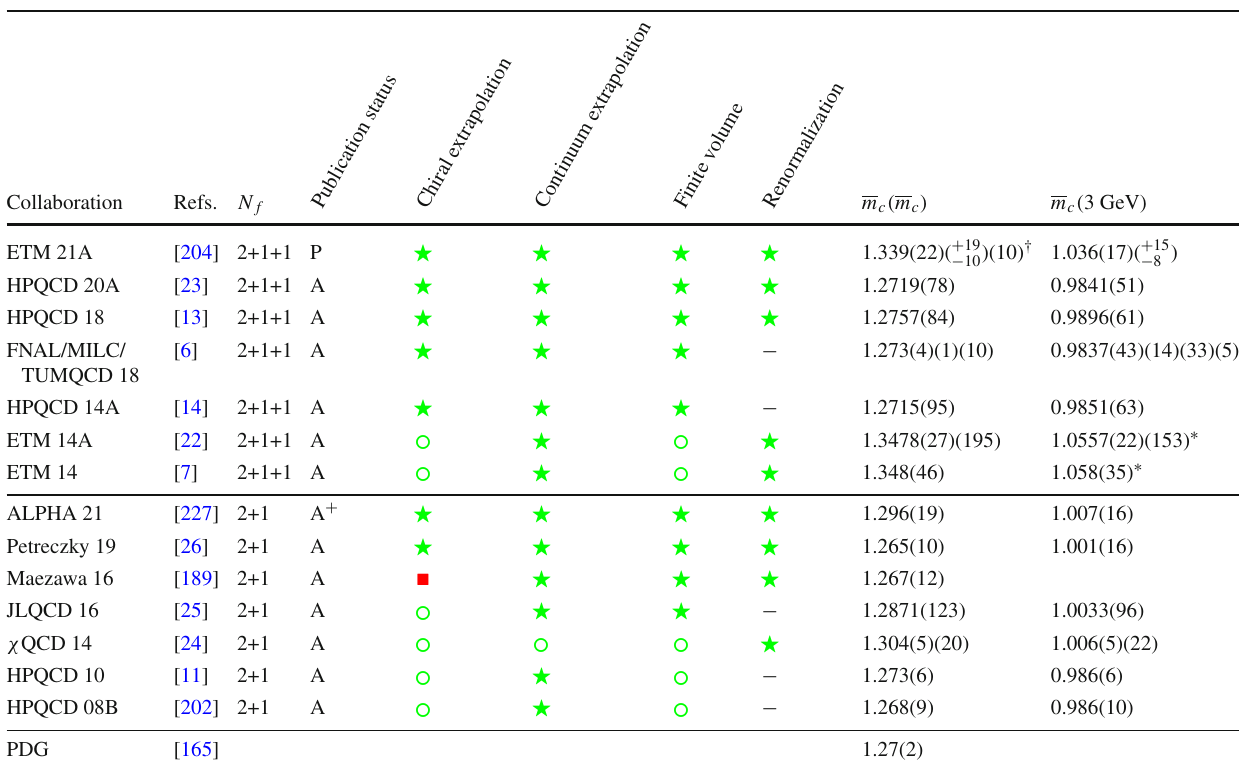
Table 12 Lattice results for the MS charm-quark mass m c ( m c ) and m c ( 3 GeV ) in GeV, together with the colour coding of the calculations used to obtain them